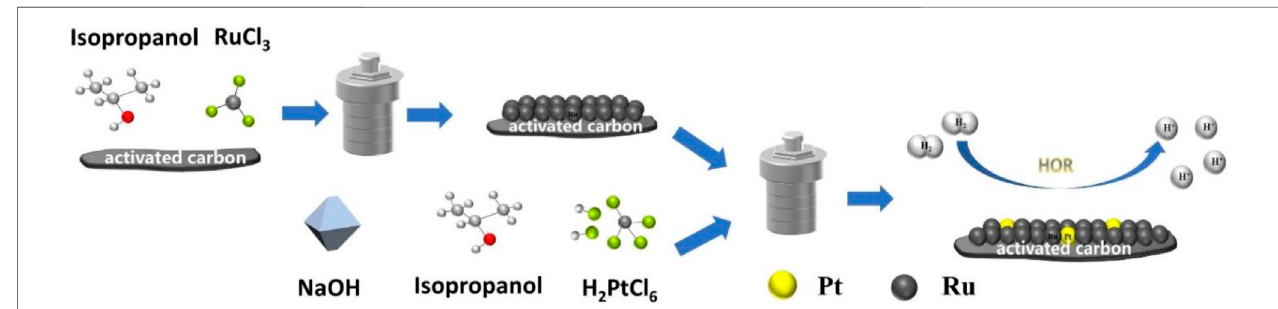
FIGURE 1 | Schematic illustration for the synthesis of PtRu/C nano assemblies through the solvothermal process.